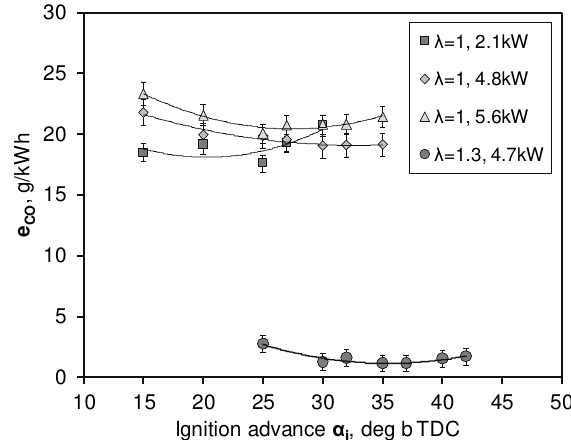
Fig. 4. Specific emission of CO vs ignition timing, throttle position and mixture composition